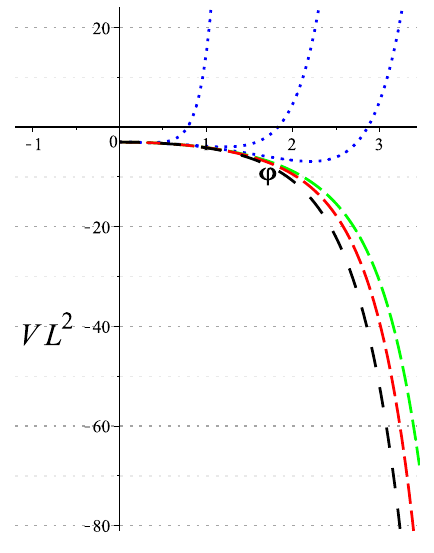
Figure 2 (b). Plot of the thermal superpoten- tial vs. ϕ ≥ 0 , for ν = 1 . 1 , 1 . 6 , 1 . 9 , 2 . 1 , 2 . 2 , 2 . 7 . There are no black holes for the dot-blue curves ν = 1 . 1 , 1 . 6 , 1 . 9